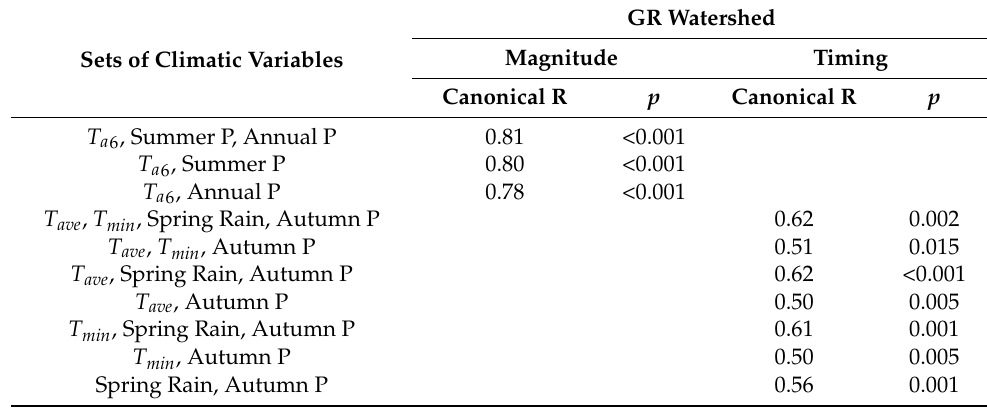
Table 5. Canonical correlation analysis between the set of climatic variables and high flow magnitude and timing in the RH